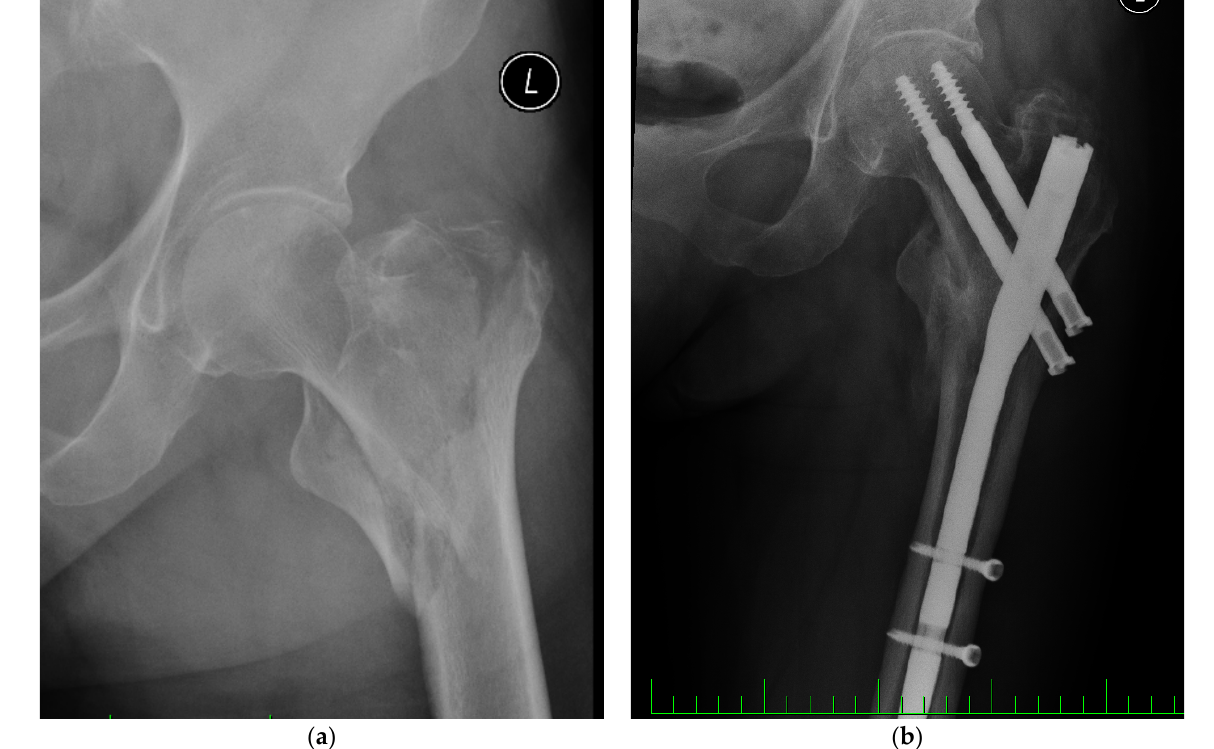
Figure 2. ( a ) Pertrochanteric fracture of femur (Evans 5, AO 31 A2.3); ( b ) fracture treatment via nail.